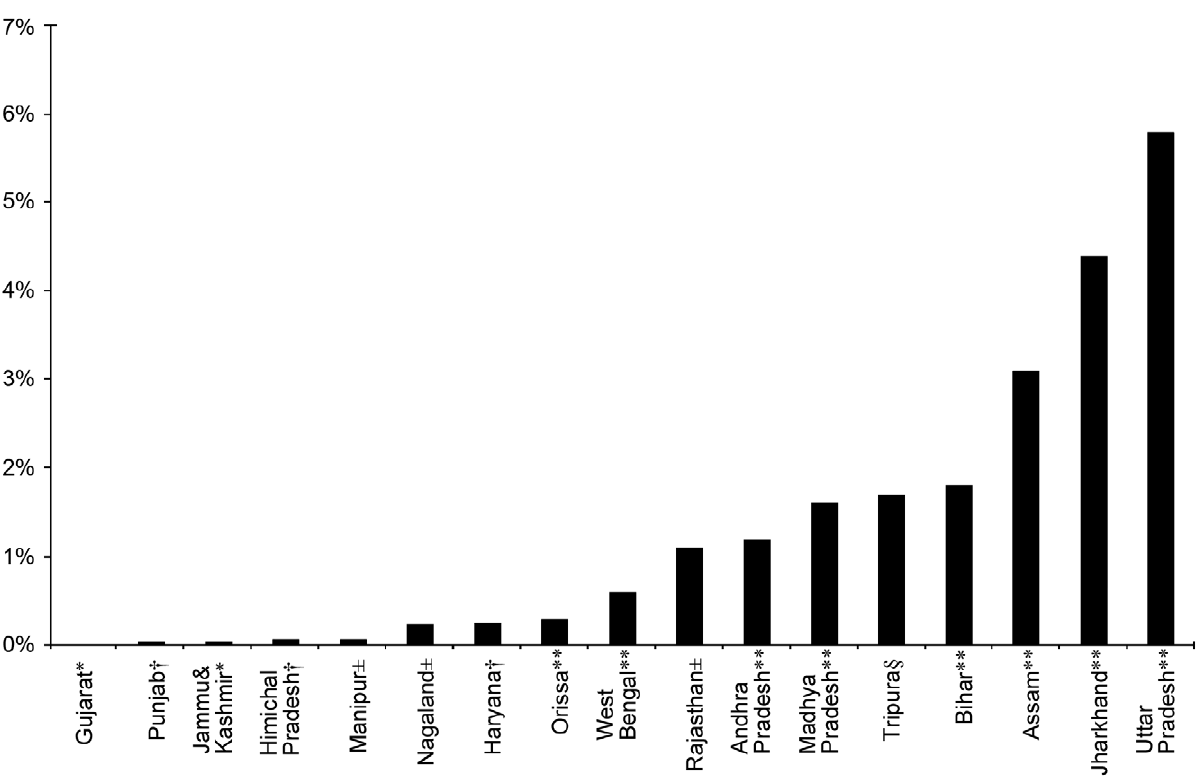
Figure 1. Prevalence of Bitot’s spots among children in 17 Indian states. Sources: * [42]; ** [5]; 6 [59]; { [60]; 1 [61].